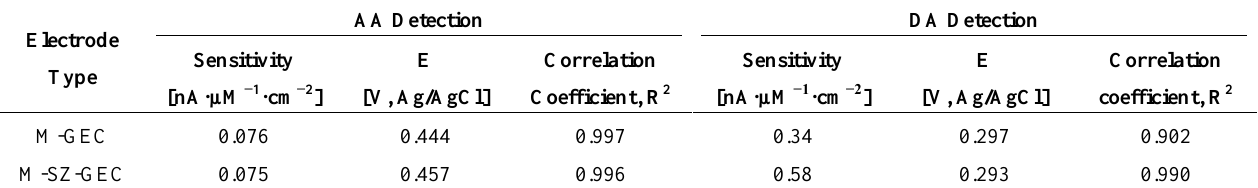
Table 2. Analytical parameters achieved by CV technique for DA (concentration range between 10–50 µM) and AA (concentration range between 100–500 µM) simultaneous detection